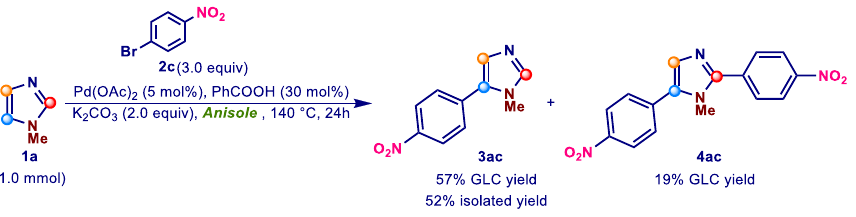
Table 3. Synthesis of 5-arylimidazole 3c by direct arylation of 1-methylimidazole ( 1a ) with 1-bromo- 4-nitrobenzene ( 2c ) in SA anisole using benzoic acid as additive.